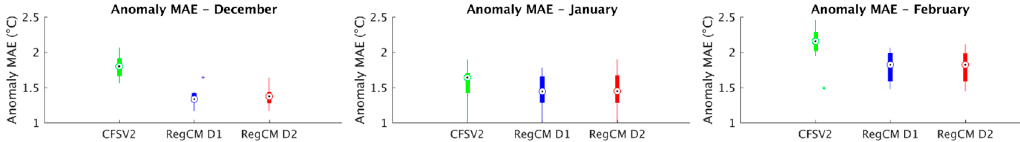
Table 1. Mean absolute error (MAE) for daily mean 2 m temperature of the climatological period in the, 5 th , 50 th , and 95 th percentiles, and inter-annual anomaly variability for the three SFSs compared